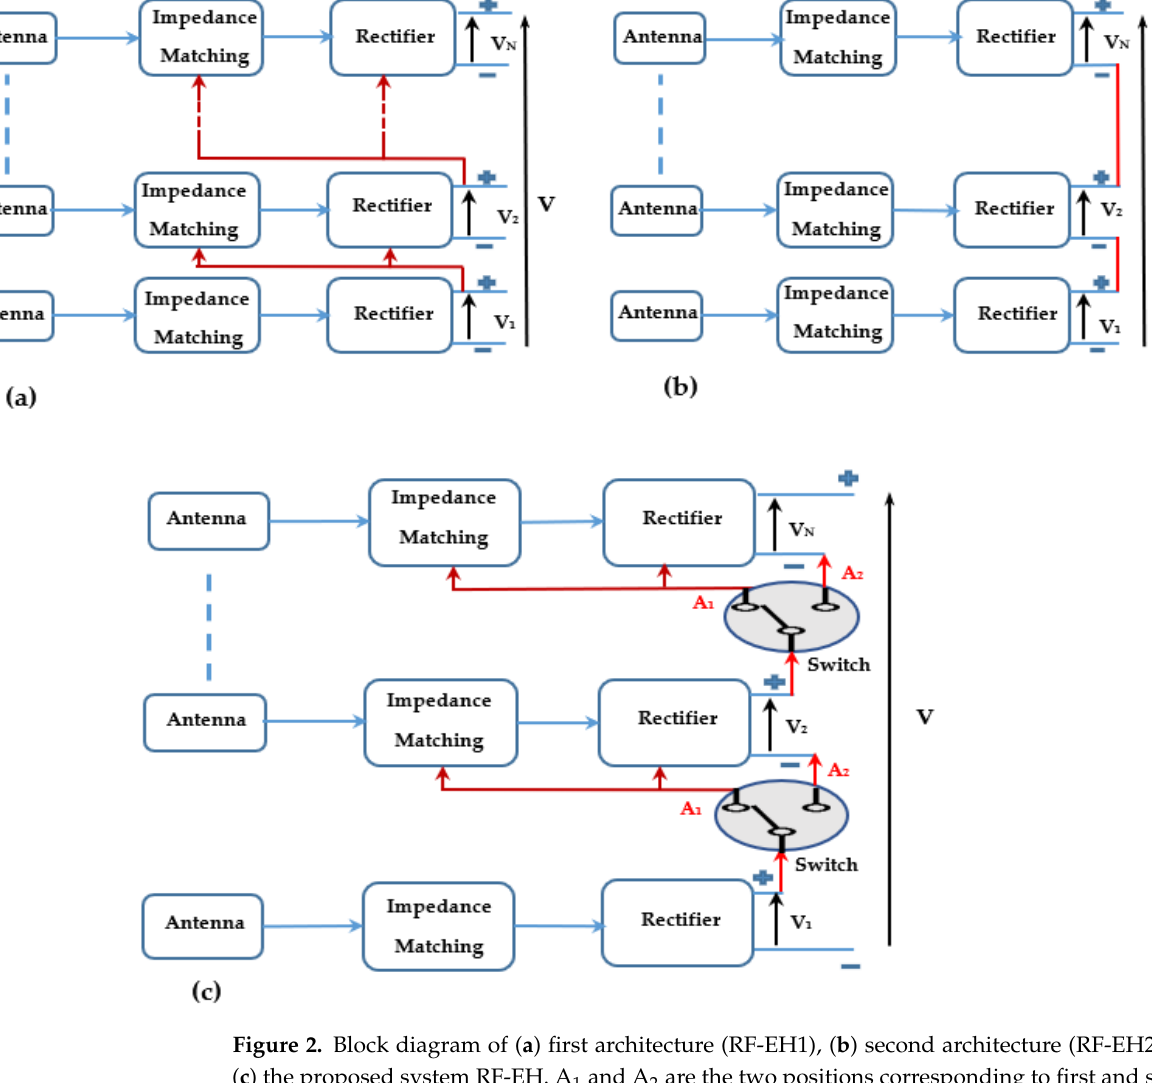
Figure 2. Block diagram of ( a ) first architecture (RF-EH1), ( b ) second architecture (RF-EH2), and ( c ) the proposed system RF-EH. A 1 and A 2 are the two positions corresponding to first and second architectures.